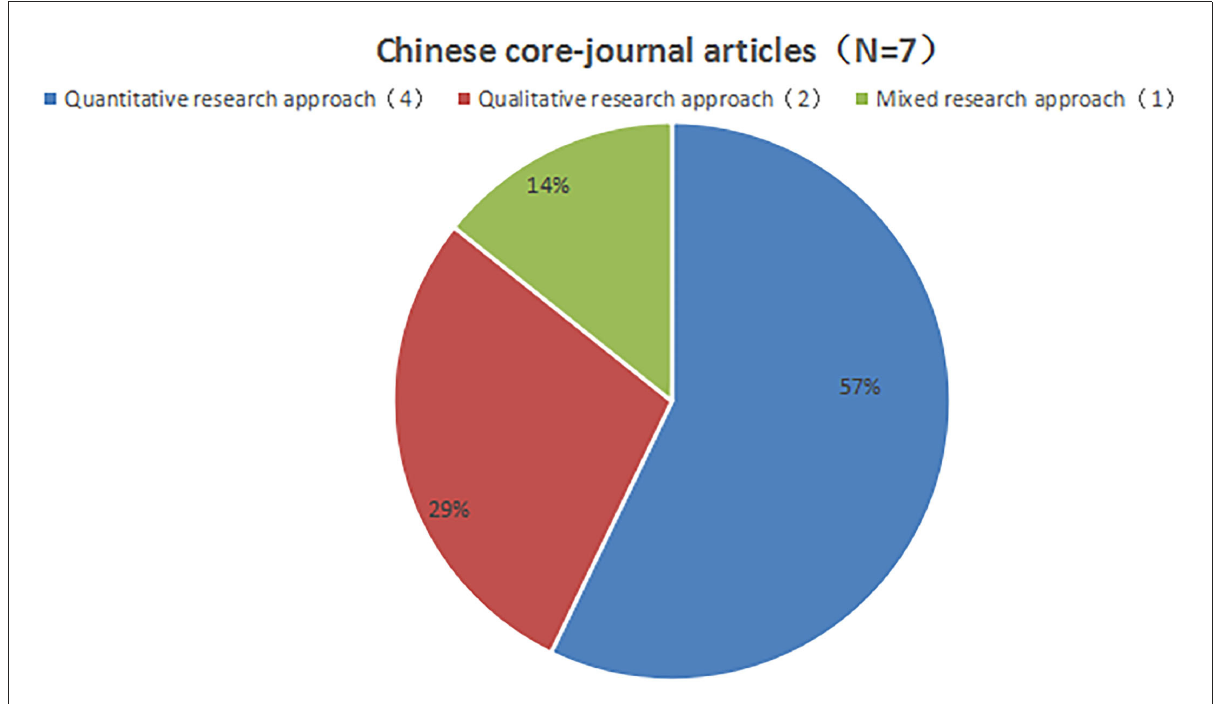
FIGURE4 Proportion of research methods in Chinese core-journal articles.